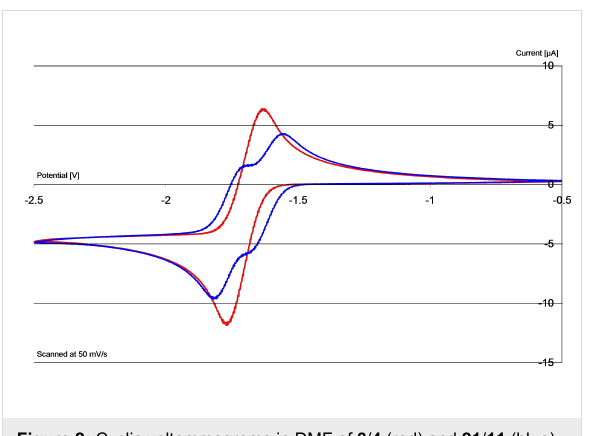
Figure 2: Cyclic voltammograms in DMF of 8 / 4 (red) and 21 / 11 (blue). Current plotted vs V (relative to Fc/Fc + as